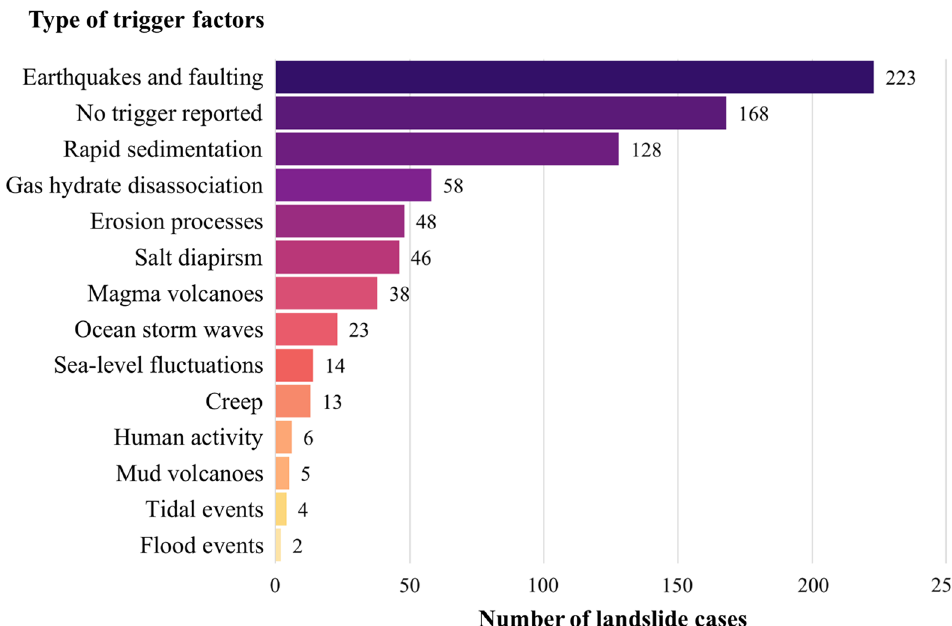
Fig. 16 Number of landslide cases associated with different trigger factors (modified by Zhu et al.